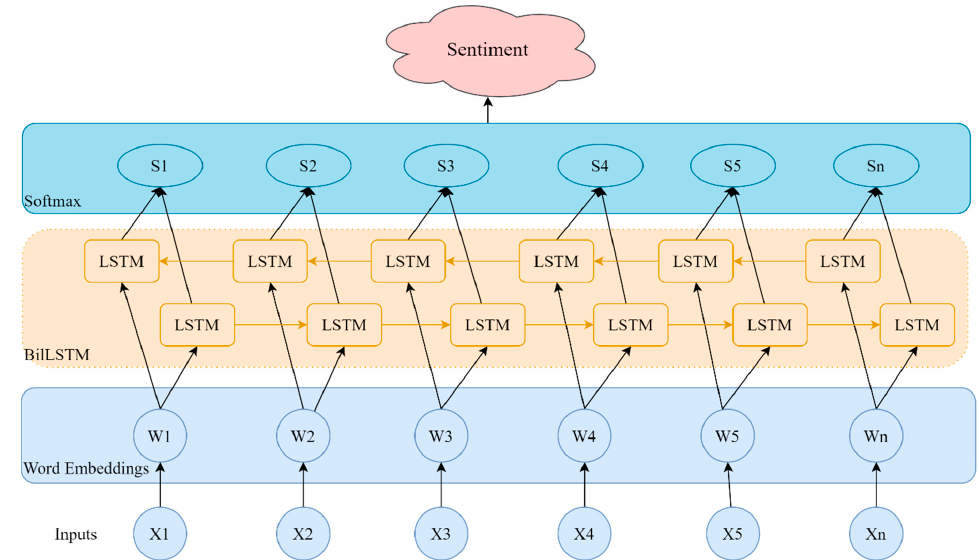
Figure 2. A biLSTM network for emotion classification.